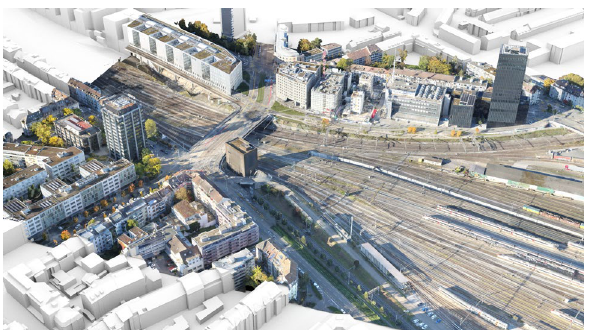
Figure 12. The resulting textured reality mesh model of the entire project area (coloured) extended with the simplified city model